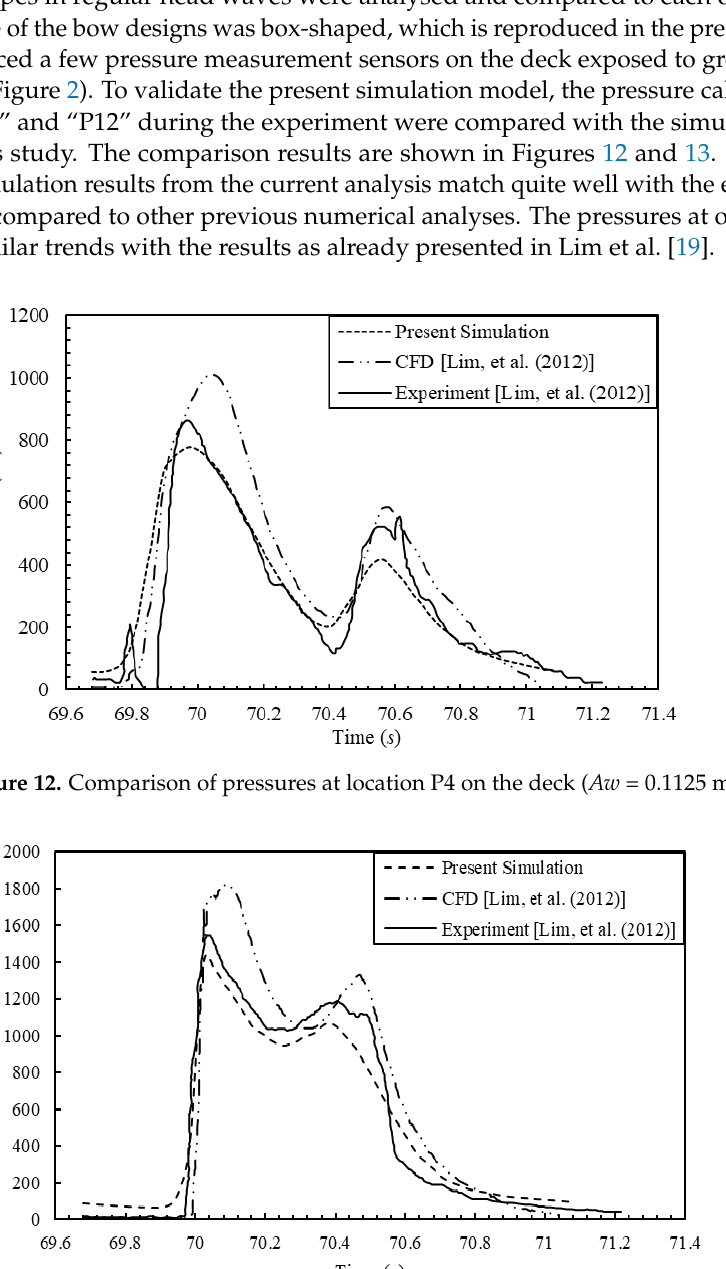
Figure 13. Comparison of pressures at location P12 on the deck ( Aw = 0.1125 m, λ = 3 .75 m).